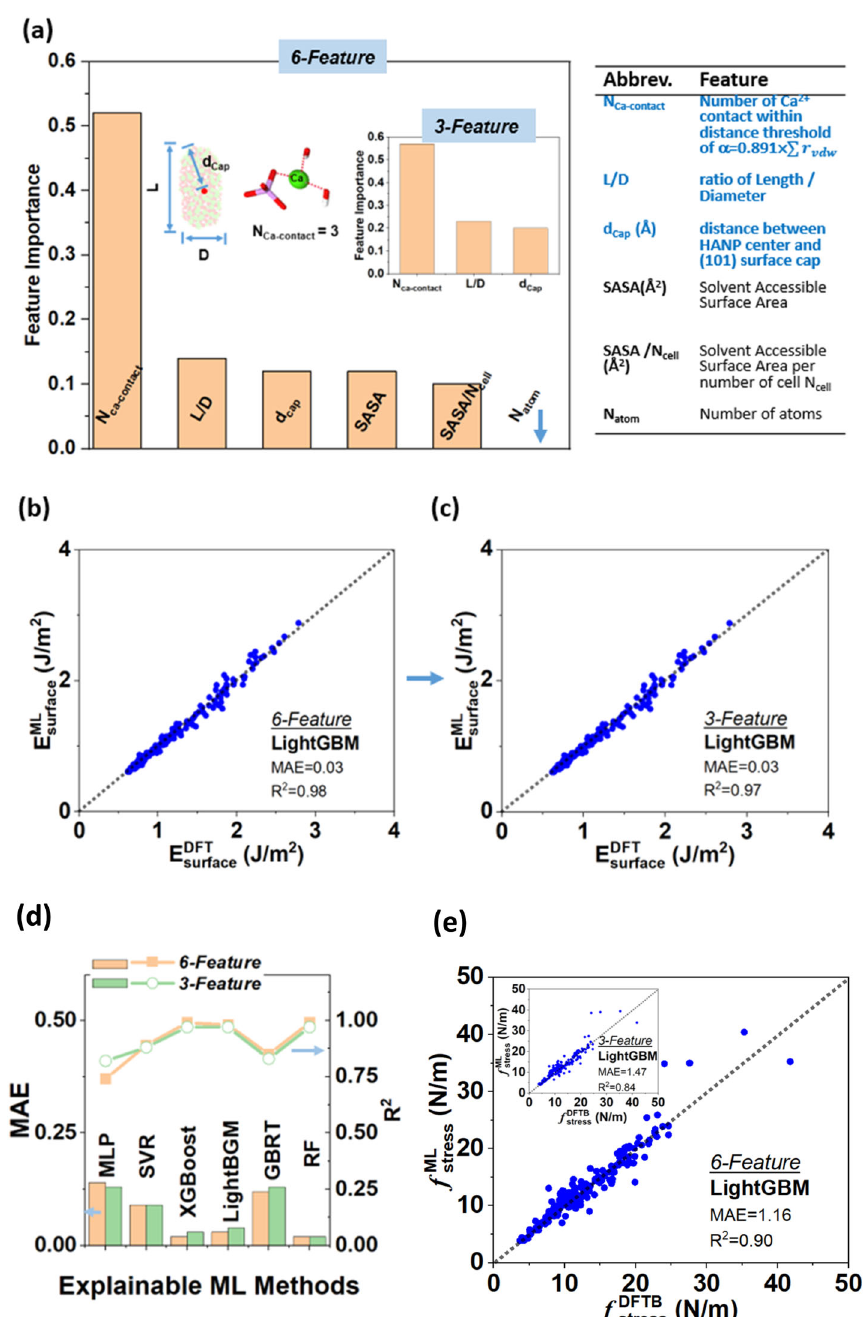
Fig. 3 Feature importance of machine learning on DFT dataset. a Feature importance of the selected features. b Machine learning of surface energies using six features. c Machine learning of surface energies using three features. d Comparison of different explainable ML methods. e Prediction of surface stress with both 6- and 3-feature